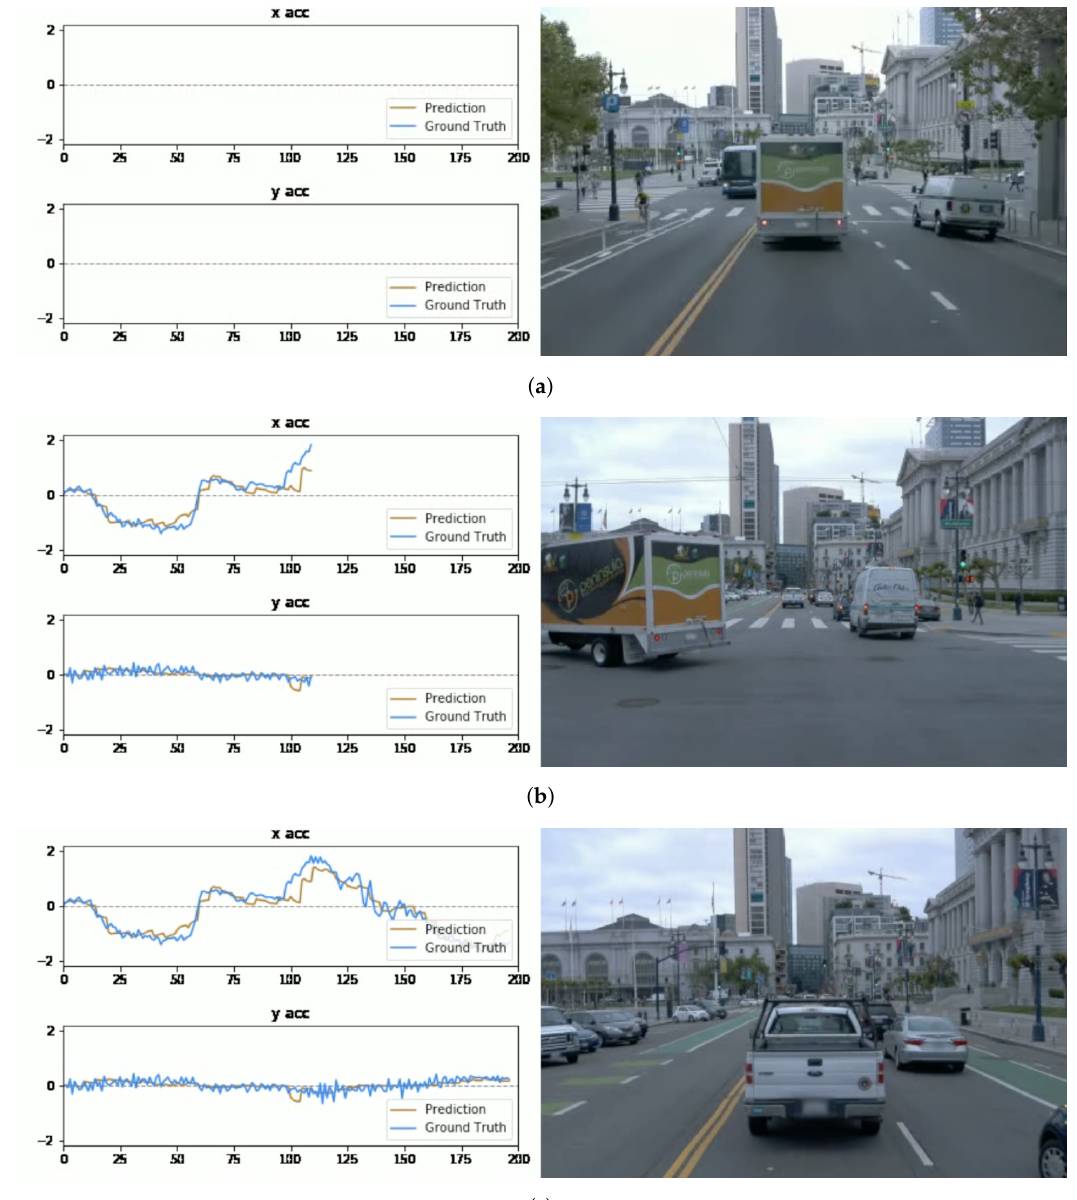
Figure 7. Key frames representing three different scenarios, all are extracted from segment-10289507859301986274 from tar validation_0001. ( a ) In the first frame of the video,